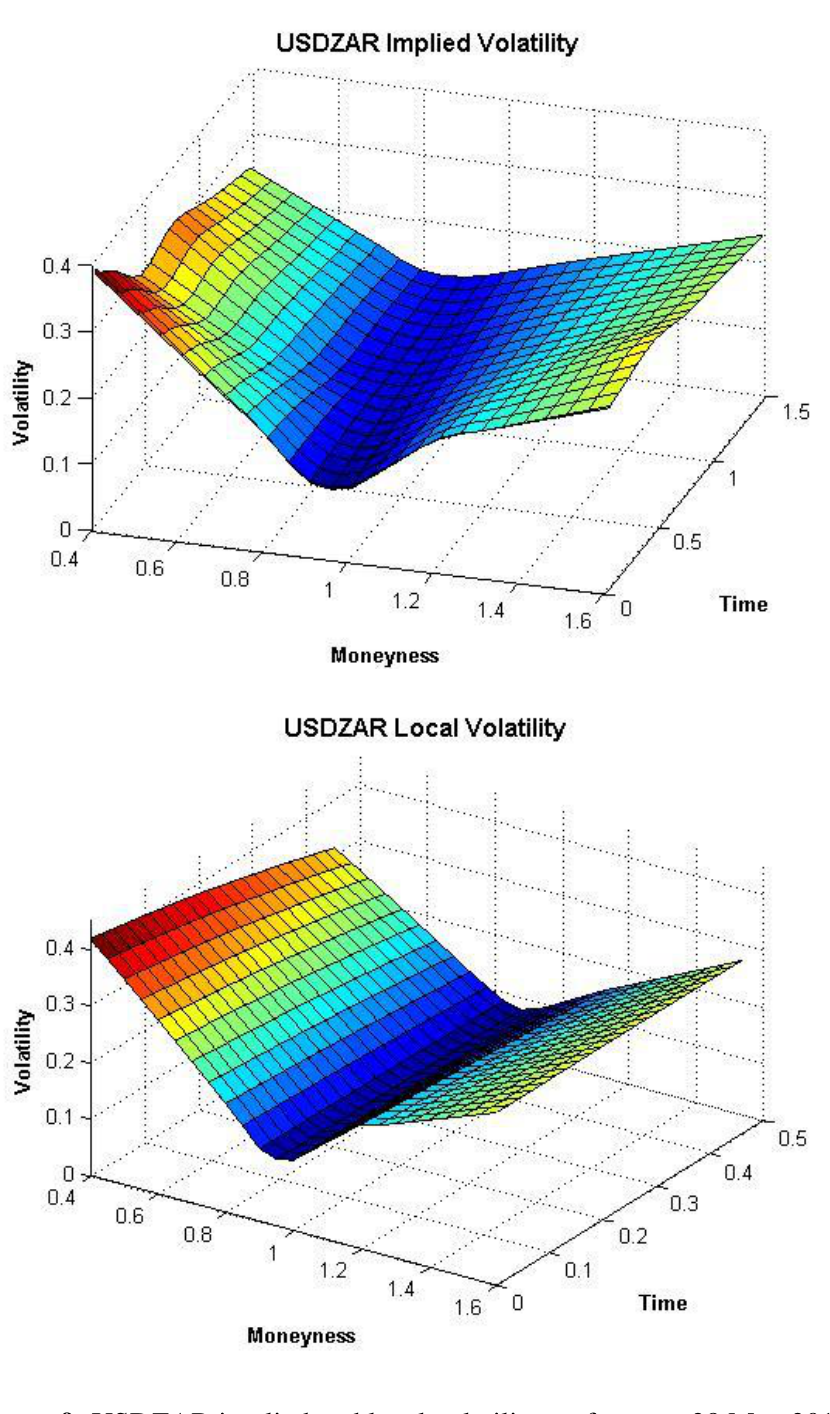
Figure 9. USDZAR implied and local volatility surfaces on 28 May